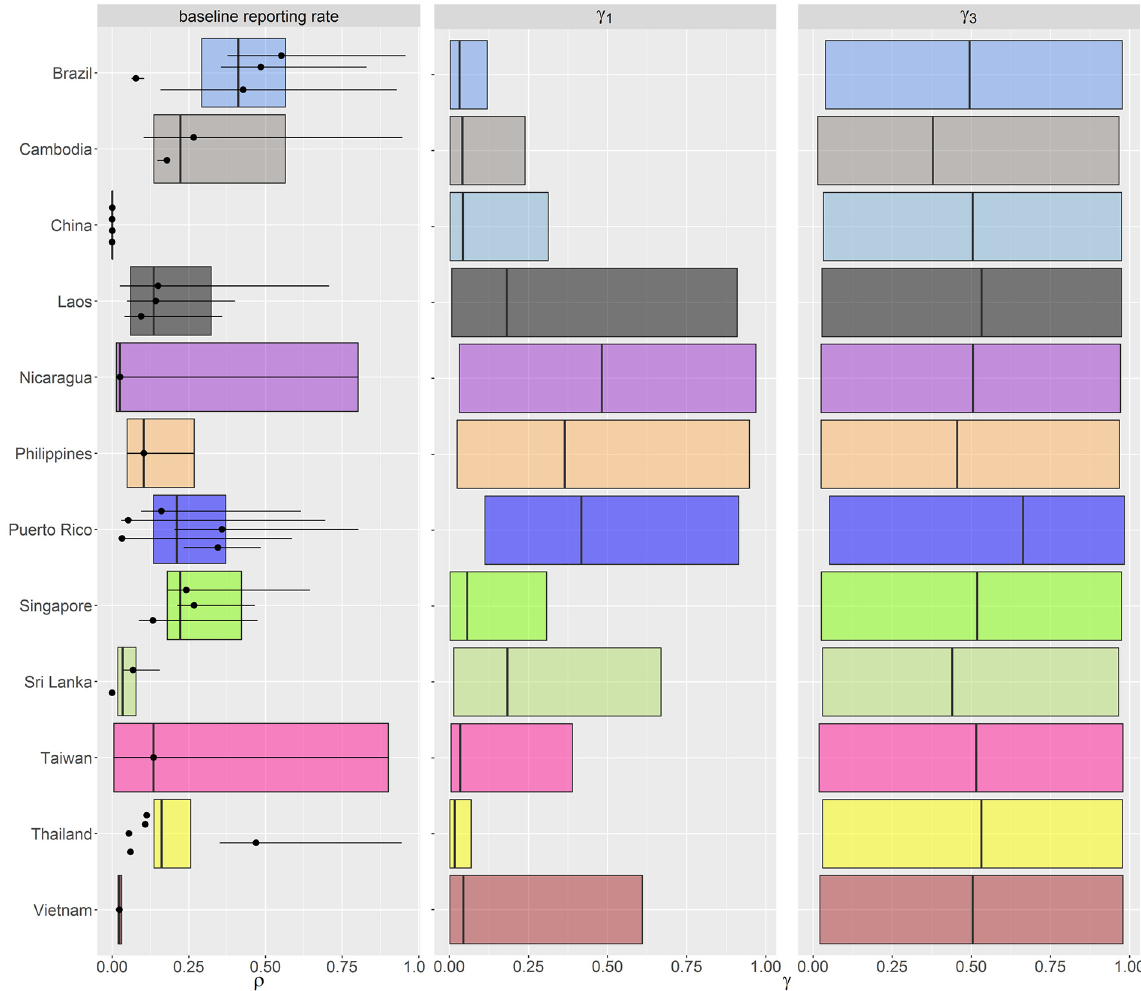
Fig 3. Summary of estimated reporting rates showing the baseline reporting rate or probability of detecting a secondary infection ( ρ ), the probability of detecting a primary infection ( γ 1) relative to a secondary infection, and the probability of detecting a tertiary/quaternary infection ( γ 3) relative to a primary infection. Each point represents the posterior median estimate and the error bars show the 95% CrI for each dataset. The box represents the country-specific central estimate calculated by taking the mean values of the MCMC output for each country (the line and limits of the box represents the posterior median and the 95% CrI respectively). A single overall value of γ 1 and γ 3 were estimated per